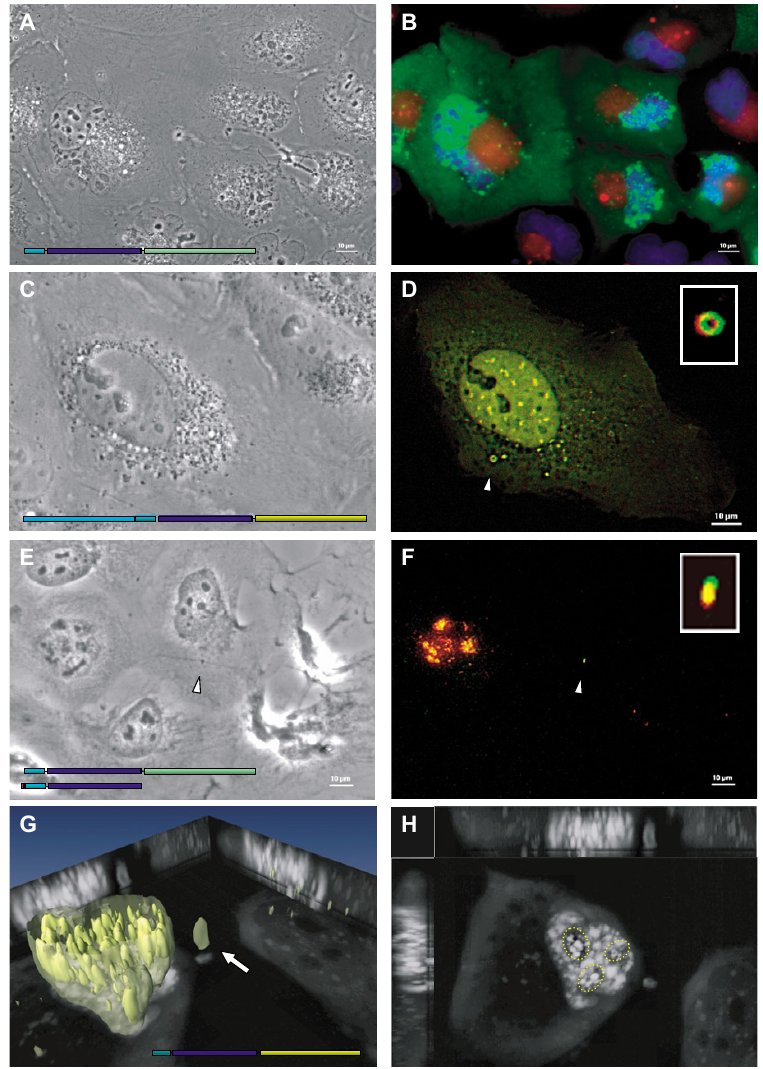
Figure 4 Intracellular localization of recombinant CB(SC) . Transient overexpression in LCLC-103H cells visualized by WFM (A- F) or OPM (G, H). A, B. Cells expressing CB(SC)-EGFP (green) were counterstained with Hoechst33342 (blue) and Lys- oTracker Red (red). Diffuse, vesicular, and granular EGFP fluorescence signals were found in the cytoplasm and highly enriched inside the nucleus sparing out the nucleoli as indicated by the DNA staining. The reticular and vesicular staining of the lyso- somal marker adjacent to the nuclear indentation did not overlap with EGFP signals. Obj. 40×/1.30 Oil. Processing of recom- binant CB(SC) and influence of the fluorescent protein marker or the total molecule size on its localization were proven by differential tagging (N- or C-terminus, respectively) as well as by means of immunocytochemistry using a N-terminal myc- epitope. C, D. Double-tagged ECFP-CB(SC)-EYFP was distributed mainly in the nucleus analogously to CB(SC), which was marked at its C-terminus only. Accumulates were found within the nucleus and adjacent to it. Fluorescence also appeared in the ring shaped midbody matrix (enlarged region in the upper right corner). Obj. 40×/0.60; processed by deconvolution. E, F. Cells coexpressing myc-CB(SC) and CB(SC)-EGFP were fixed by acetone/methanol and immunostained against myc and GFP. A tight colocalization of both was found (E and F); the constructs were found mainly in the nucleus and stained the midbody (marked by the arrowhead; see inset). Obj. 40×/0.60. G, H. Optical sections of CB(SC)-EYFP expressing cells were subjected to spatial reconstruction (G: 3D-visualisation; H: orthogonal projection). Isosurfaces obtained by arbitrary fluorescence inten- sity thresholds represent distinct compartments (granules: opaque; nucleus and midbody: transparent). In the given cellular state, only a weak expression in the cytoplasm is found. The main signals arise from granular inclusions within the nucleus including distinct regions inside the nucleoli (marked by dashed lines in H) as well as from enrichment in the midbody (arrow). Obj. 63×/1.32 Oil. ROI: 72 × 59 × 11 µ m 3 (= 464 × 380 × 25